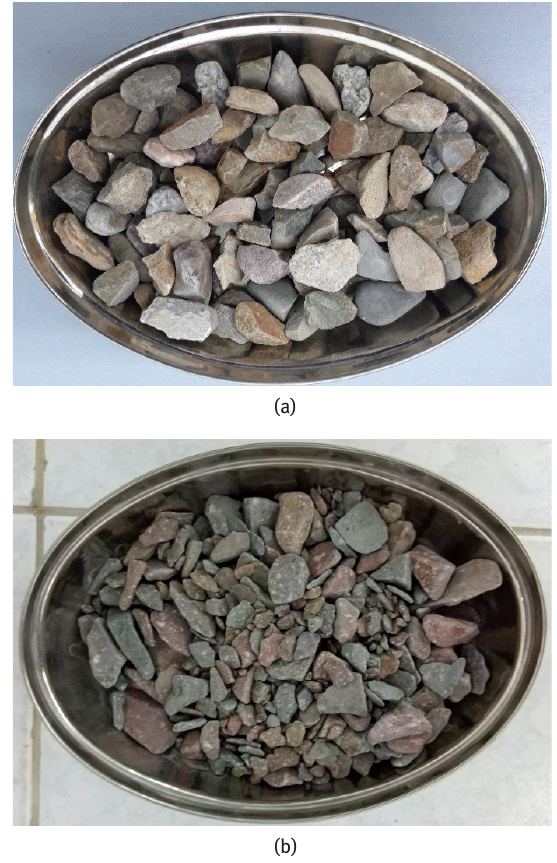
Figure 5: Sample before (a) and after (b) abrasion